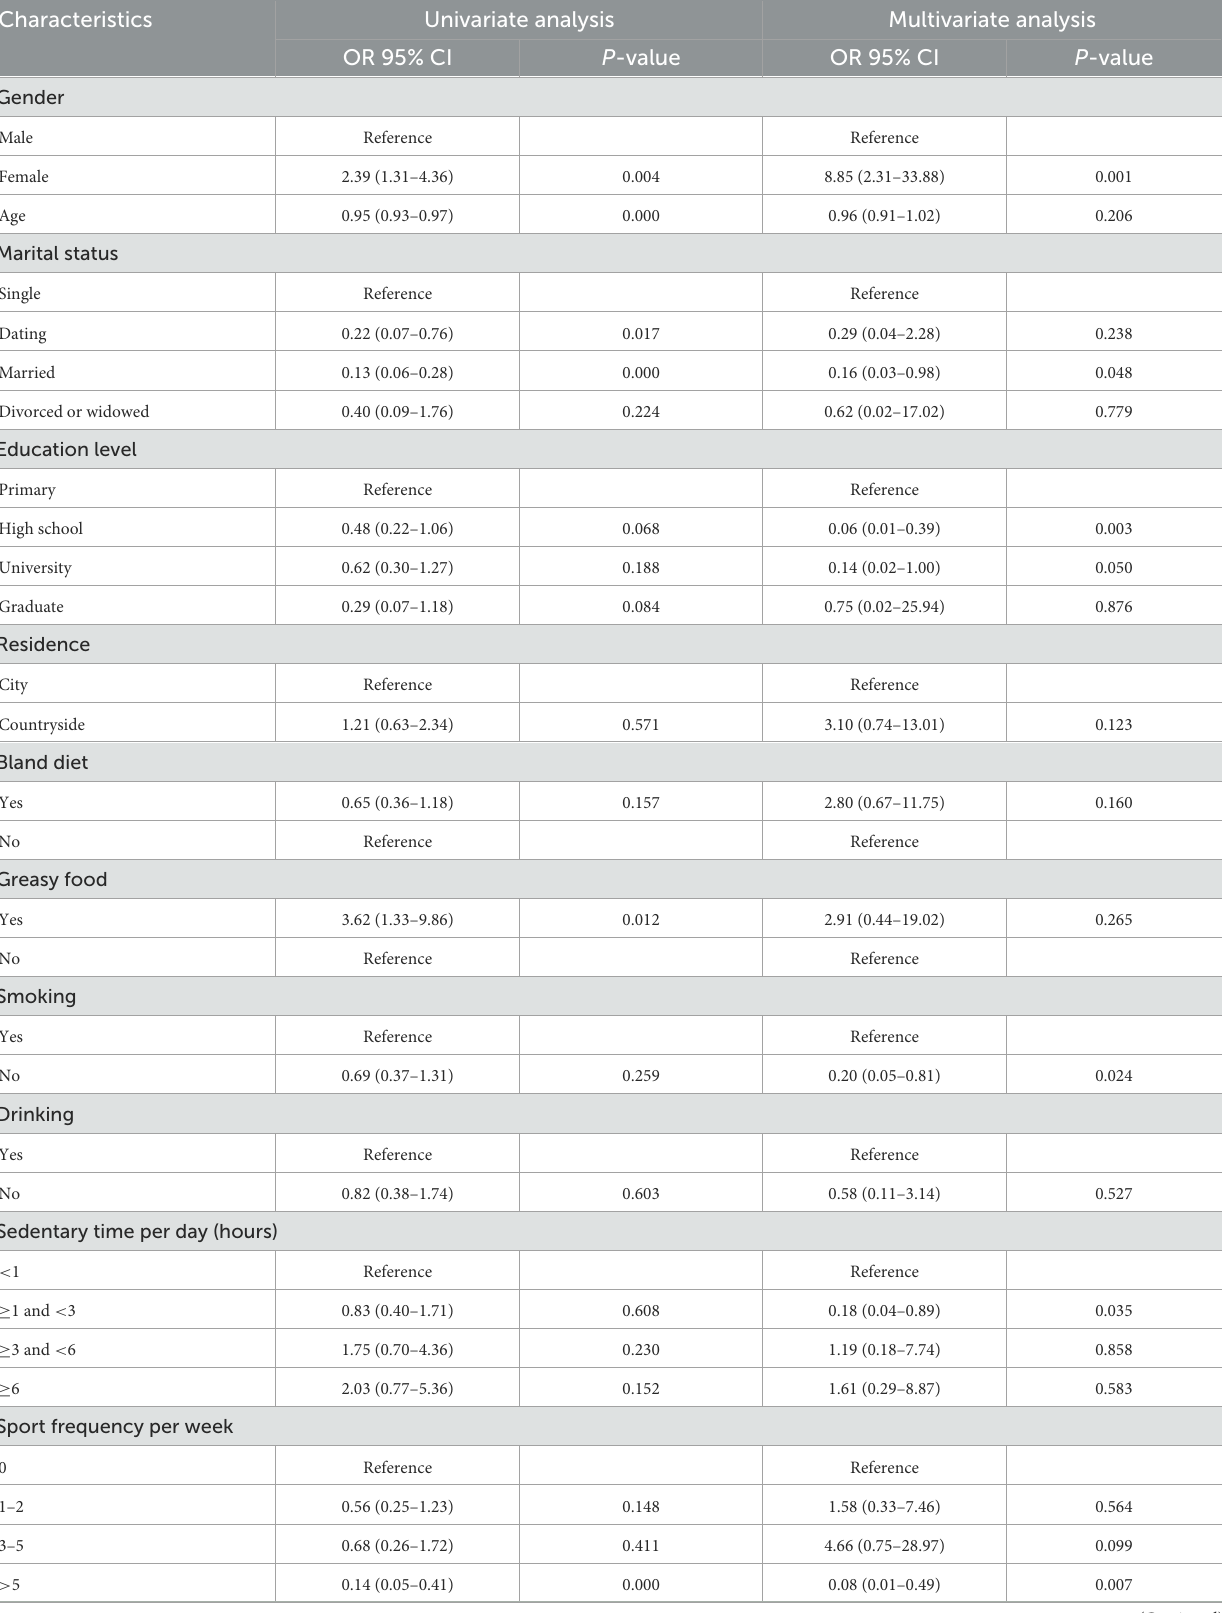
TABLE 3 Selection of nomogram predictor based on the univariate and multivariate analyses in the training group.